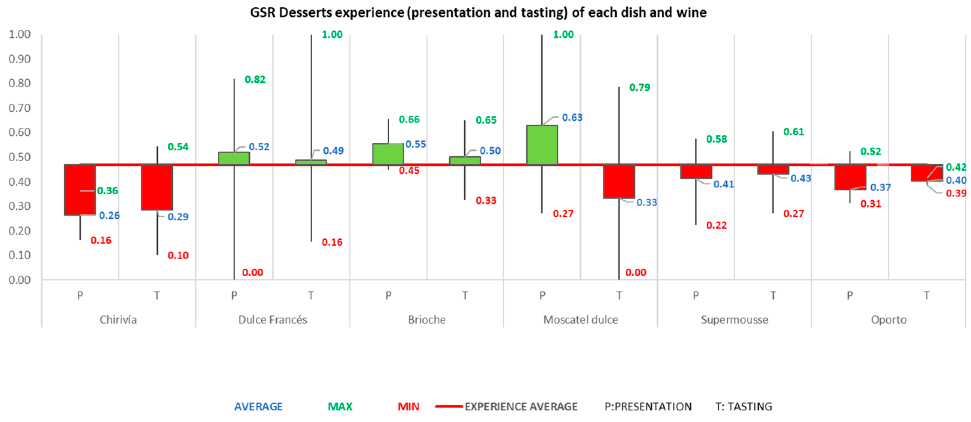
Figure 4. Galvanic skin response analysis for each dish and wine (presentation and tasting): Main courses group. Source: Original work from the authors. Figure 5. Galvanic skin response (GSR) analysis for each dish and wine (presentation and tasting): Desserts group. Source: Original work from the authors.